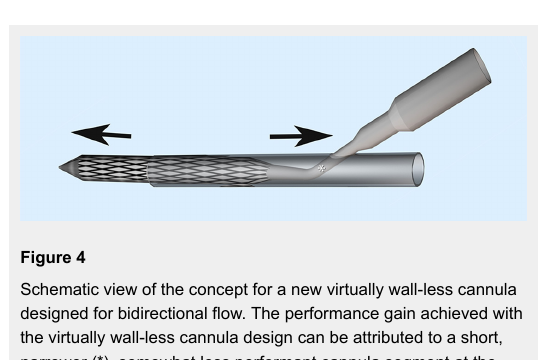
Thin wall percutaneous cannula (top), collapsed virtually wall-less cannula prior to insertion (centre), and virtually wall-less cannula expanded in situ